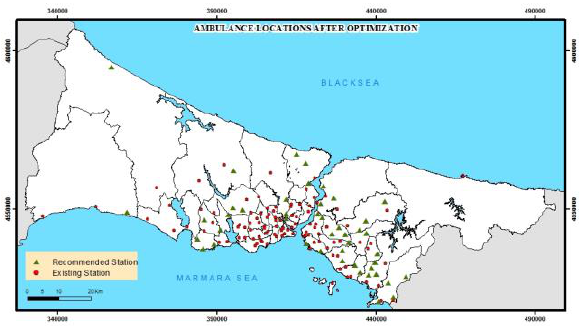
Figure 4. Distribution of ambulance stations after optimization